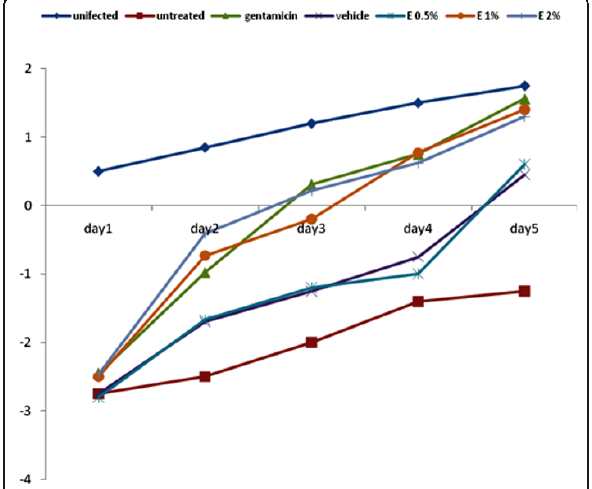
Figure 1 Effect of the dose of gel-extract on weight gain as a function of time